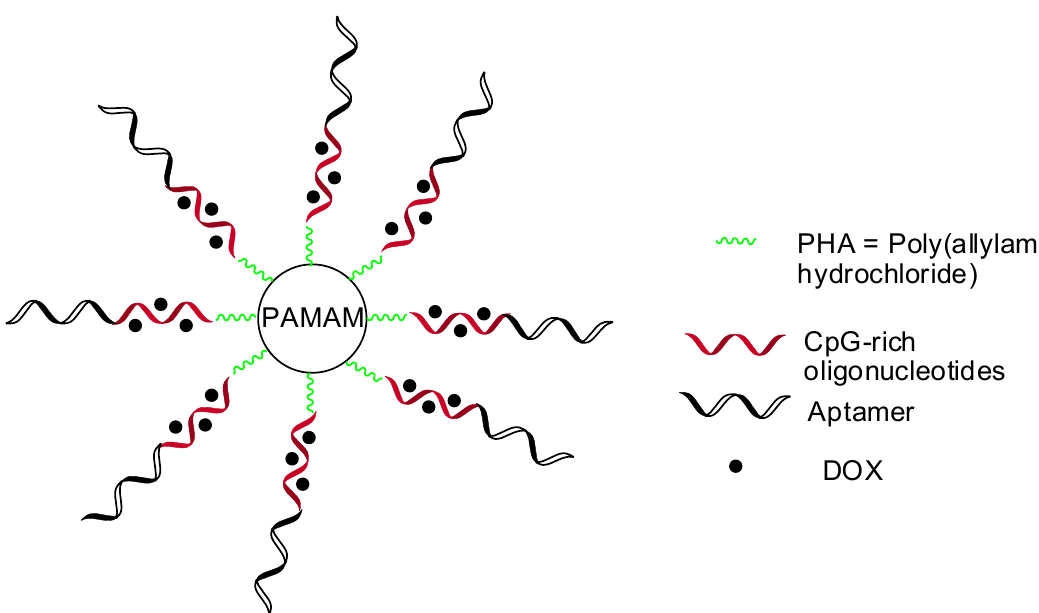
Figure 7. Aptamer-PAMAM dendrimers coupled with CpG-rich oligonucleotides loading doxorrubicin–chemotherapeutic drug (DOX) [71].